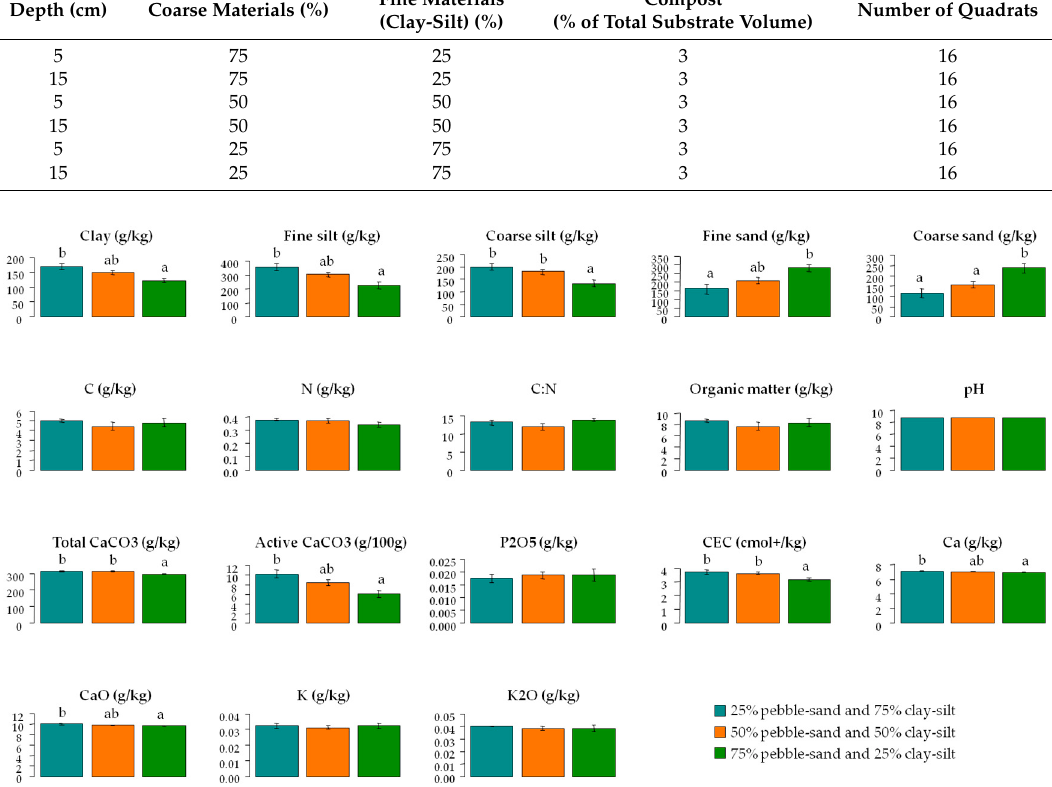
Figure 1. Physical and chemical analyses of the different substrates carried out in summer 2016 and performed by the soil analysis laboratory at INRA (Institut National de la Recherche Agronomique) in Arras by extraction (pH water ratio 1:5) [44], CaCO3 using a Bernard calcimeter [45], organic C [46] and total N by dry combustion [47,48], C:N ratio, Cation Exchange Capacity (CEC) and exchangeable K+ by Metson [49,50], plant available P [51] and the particle-size distribution in five fractions by the Robinson method without prior decarbonization (clay (<0.002 mm), fine silt (0.002–0.02 mm), coarse silt (0.2–2 mm), fine sand (0.05–0.2 mm) and coarse sand (0.2–2 mm)). The given values are means ± standard errors. Two values in the same row with a different letter are significantly different according to Tukey post hoc tests or Mann-Whitney-Wilcoxon tests (with Bonferroni adjustment [52]).